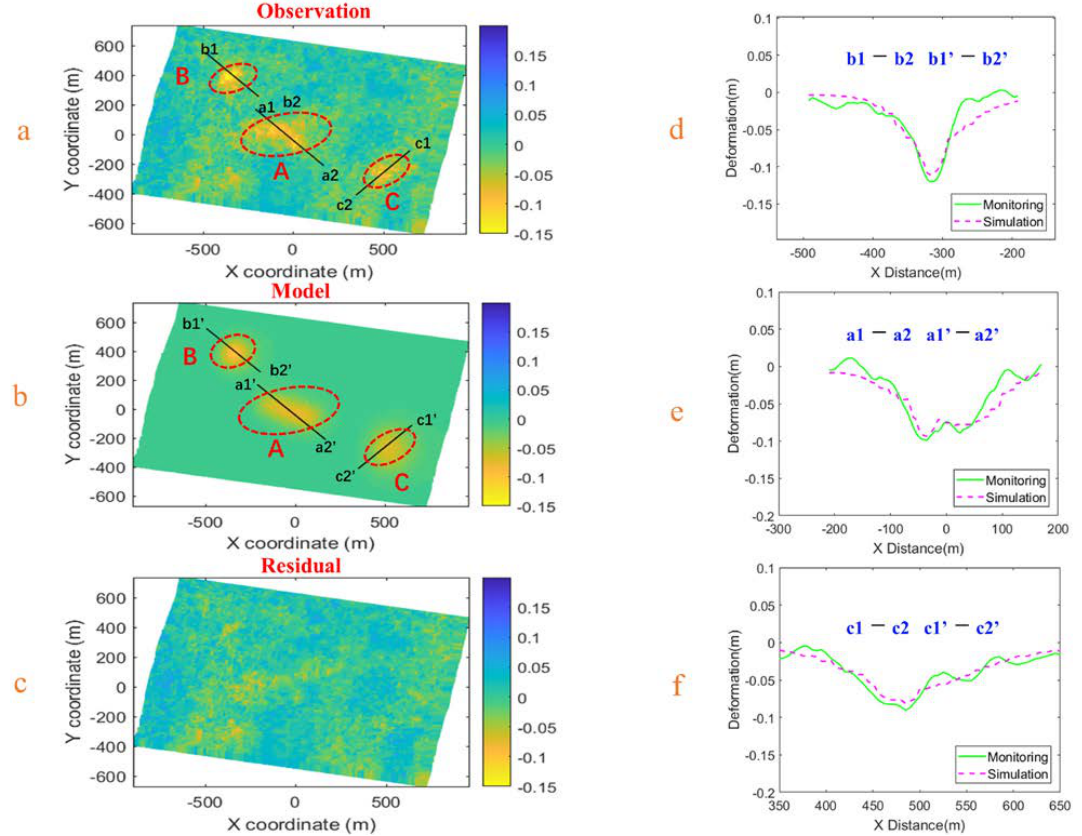
with the simulated deformation via three profiles, as shown in Figure 6d–f. The solid green lines represent the InSAR observation data, which correspond to the a1-a2, b1-b2, and c1-c2 profiles, respectively, while the purple dashed lines represent the simulation data, which correspond to the a1 (cid:48) -a2 (cid:48) , b1 (cid:48) -b2 (cid:48) , and c1 (cid:48) -c2 (cid:48) profiles, respectively. The correlation analysis between the InSAR observations and the simulation results is shown in Figure 7, in which the solid red lines represent the linear fit of the model and the black dashed lines represent the 1:1 line. The calculated R 2 = 0.81 for the subsidence zone B profile (b1-b2, b1 (cid:48) -b2 (cid:48) ), R 2 = 0.889 for the subsidence zone A profile (a1-a2, a1 (cid:48) -a2 (cid:48) ), and R 2 = 0.879 for the subsidence zone C profile (c1-c2, c1 (cid:48) -c2 (cid:48) ). The high correlation indicates that the parameters of the model inversion are accurate.